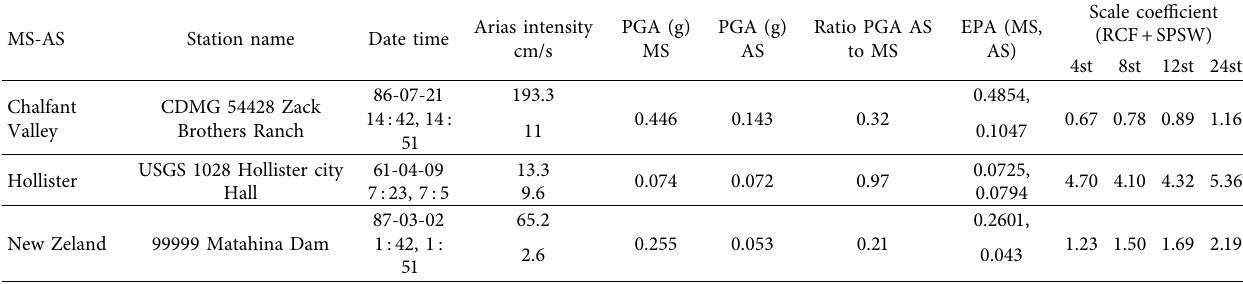
Table 10: Result for scaling the frst category records of seismic scenario (with maximum